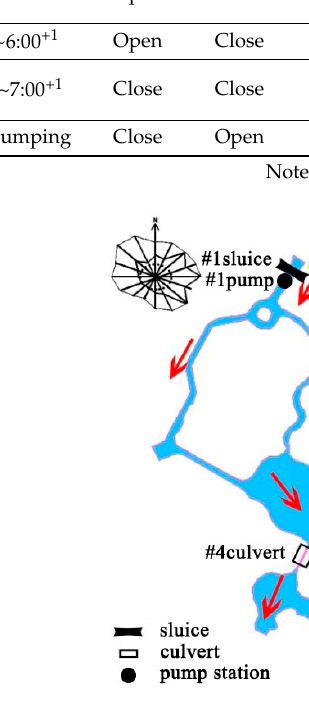
Figure 6. Route of water diversion through pump.